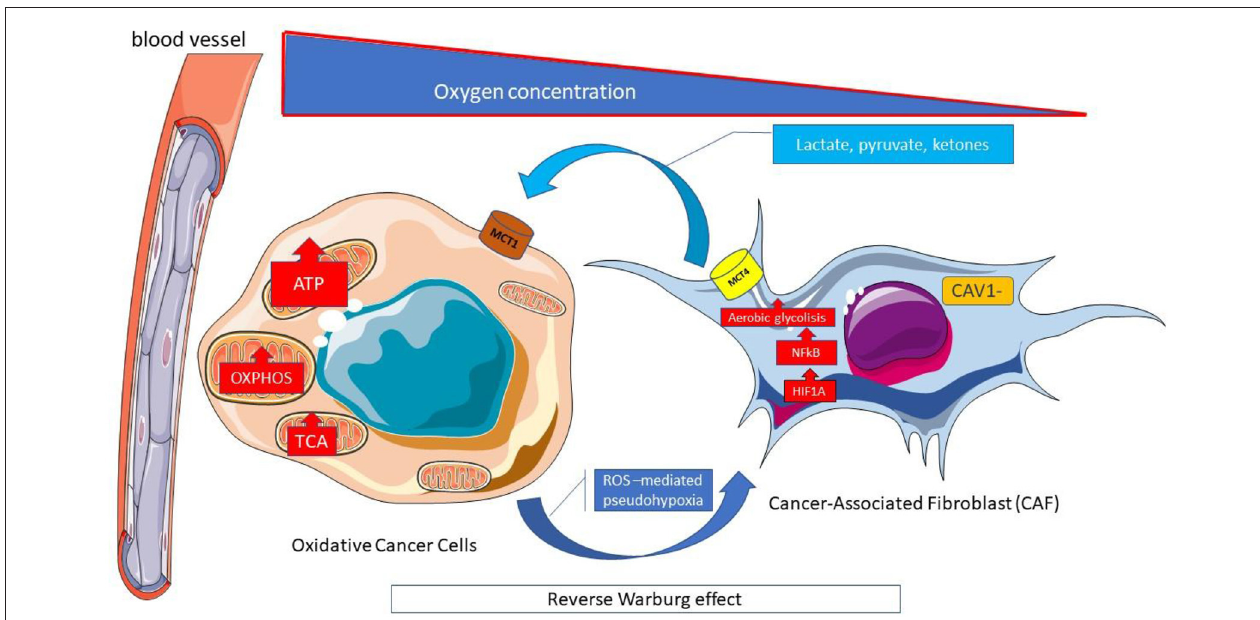
FIGURE 6 | Reverse Warburg effect. Cells within tumors interact metabolically with the transfer of catabolites from supporting stromal cells to adjacent tumor cells. The reverse Warburg effect describes when the aerobic glycolysis of stromal fibroblasts associated with cancer metabolically supports adjacent cancer cells. The stromal-cancer metabolic coupling, allows cancer cells to generate ATP from substrates (lactate, pyruvate, ketonic bodies) provided by stromal cells, increase proliferation and reduce apoptosis. The Monocarboxylated transporter 4 MCT4 transporter is involved in the release of monocarboxylates from the tumor-associated fibroblast. It is regulated by catabolic transcription factors such as hypoxia inducible factor 1 alpha (HIF1A) and kappa-light-chain-enhancer nuclear factor of activated B-cells (NF- κ B), and is highly expressed in cancer-associated fibroblasts. In contrast, MCT1 allows the absorption of these catabolites by neoplastic cells where it is highly expressed. ATP, Adenosine triphosphate; CAV, Caveolin; HIF1A; Hypoxia-inducible factor 1-alpha; MCT, Monocarboxylated transporter; NF- κ B, Nuclear factor kappa B; OXPHOS, Oxidative phosphorylation; ROS, Reactive oxygen species; TCA, Tricarboxylic